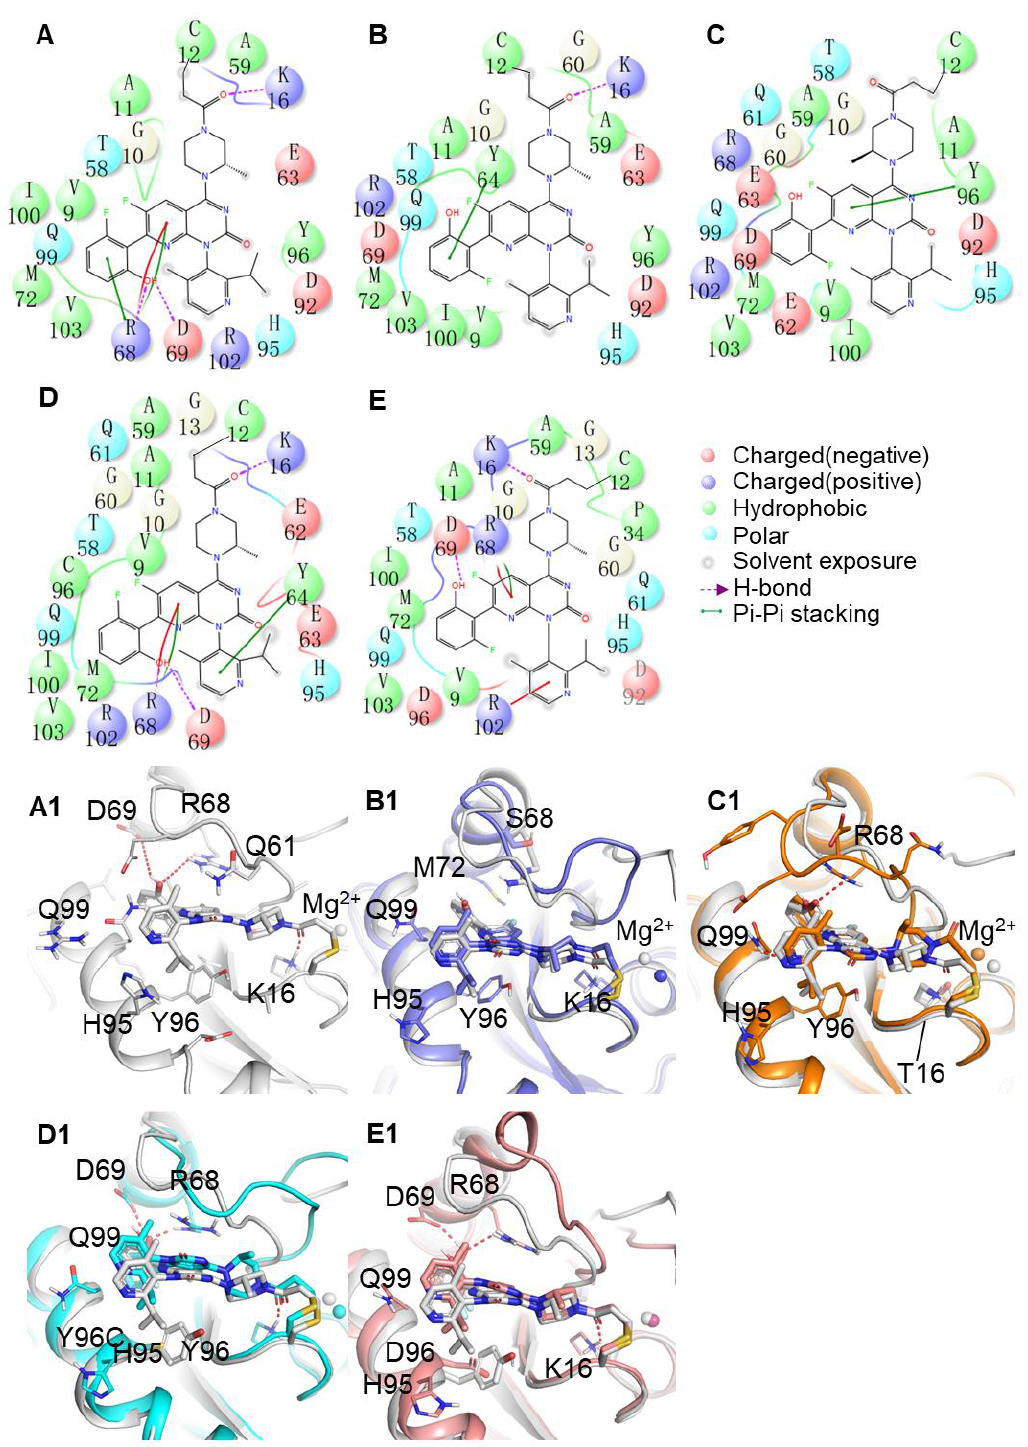
Figure 5. ( A – E ) Binding modes of the studied AMG510 bound to KRAS G12C, G12C-R68S, G12C- K16T, G12C-Y96C and G12C-Y96D, respectively. ( A1 – E1 ) The 3D presentations of the binding modes in the switch-II pocket of KRAS G12C, G12C-R68S, G12C-K16T, G12C-Y96C and G12C-Y96D with AMG510 shown in gray, orange, blue, cyan, and pink, respectively. The Mg 2+ is shown as a sphere.